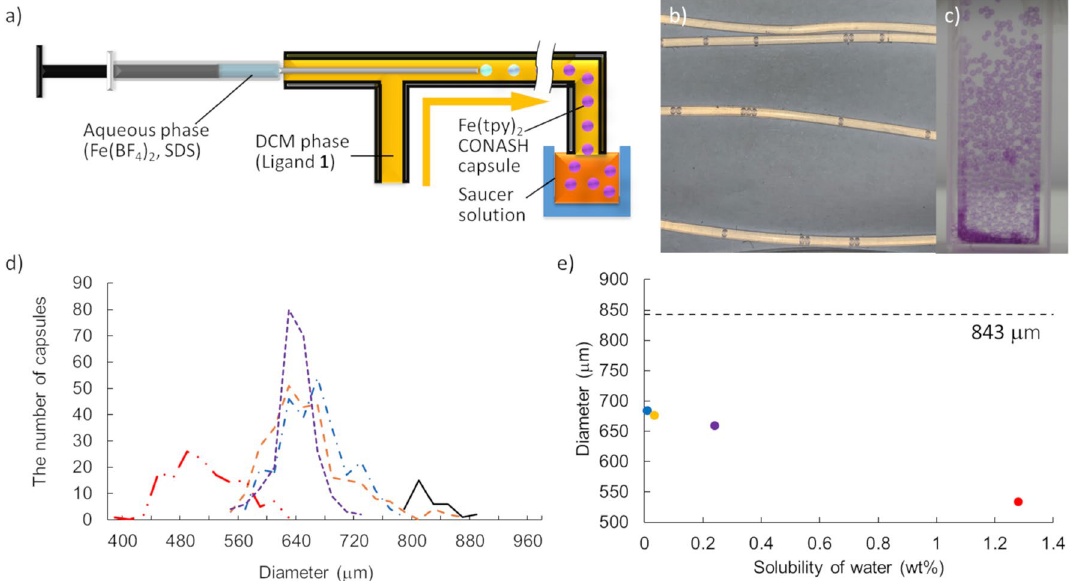
Figure 3. Syringe-pump method to form Fe(tpy) 2 CONASH capsules. ( a ) Schematic of the syringe-pump method. ( b ) Photograph of Fe(tpy) 2 CONASH capsules during the formation in tubes. ( c ) Photograph of Fe(tpy) 2 CONASH capsules in hexane. ( d ) Size distribution of Fe(tpy) 2 CONASH capsules in the tube (solid line) and saucer organic solvents; diethyl ether (two-dot chain line), DCM (dotted line), toluene (broken line), and hexane (chain line). ( e ) Diameter of Fe(tpy) 2 CONASH capsules vs. solubility of water in a given organic solvent; diethyl ether (red), DCM (purple), toluene (orange), and hexane (blue). The diameter in the tube, 843.2 μm is given for